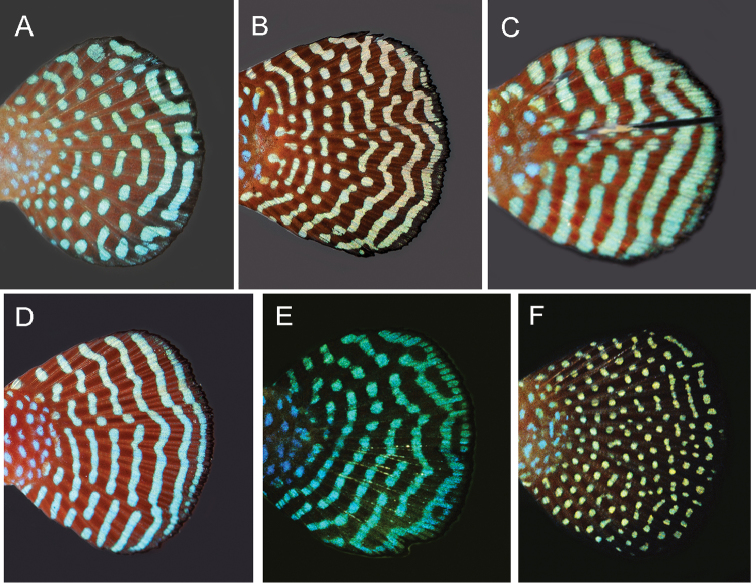
Caudal fin of live males of the Hypsolebiasmagnificus species complex. AH.harmonicus, holotype, UFRJ 6696, 29.4 mm SLBH.gardneri sp. n., paratype, UFRJ 6797, 34.4 mm SLCH.hamadryades Costa sp. n., paratype, UFRJ 6895, 24.8 mm SLDH.magnificus, specimen from Gado Bravo, UFRJ 4959, 31.2 mm SLEH.magnificus, topotype not preserved, about 25 mm SLFH.picturatus. Paratype, UFRJ 5053, 38.6 mm SL. Photographs by WJEM Costa.